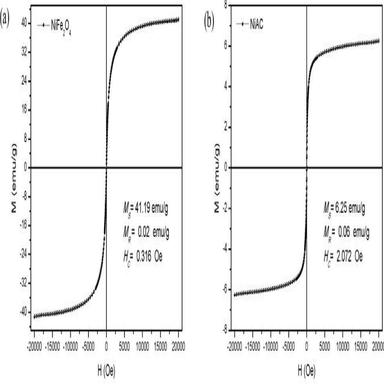
Magnetic hysteresis loops of (a) NiFe2O4 and (b) NiAC.